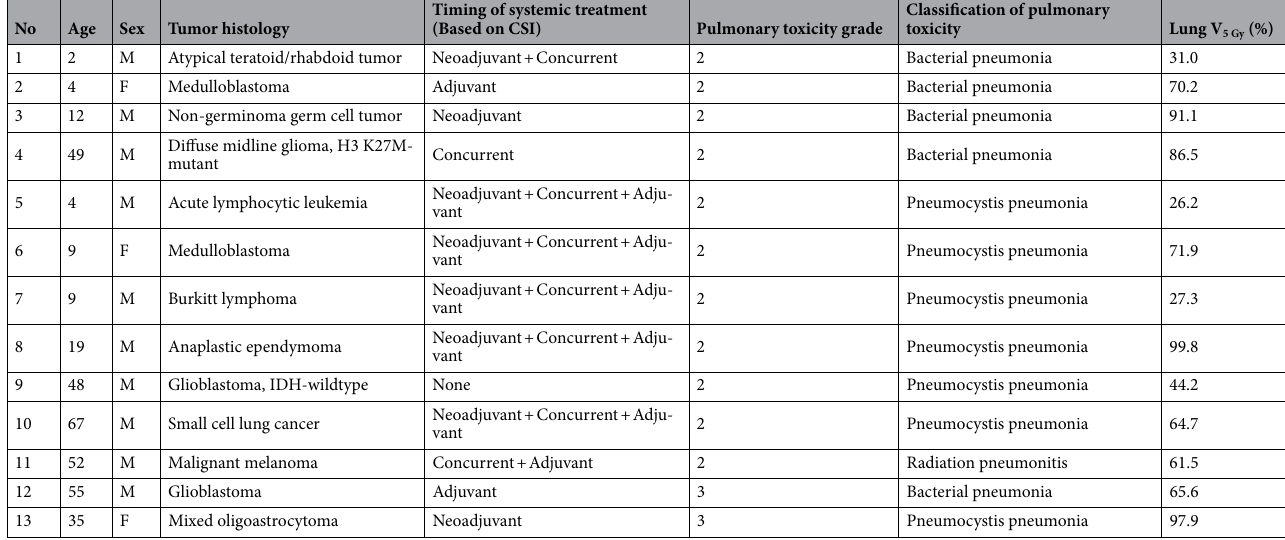
Table 3. Characteristics of patients with grade 2 + pulmonary toxicities. CSI, craniospinal irradiation; Gy, gray;